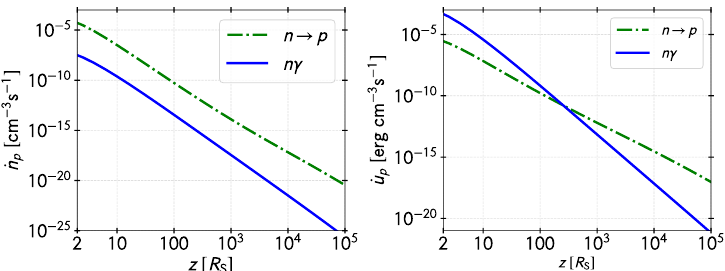
Figure 11. Injection of protons in the funnel by the two processes mentioned in the text. Left panel: Number of protons created per unit time and volume. Right panel: Same plot for the energy injected in protons per unit time and